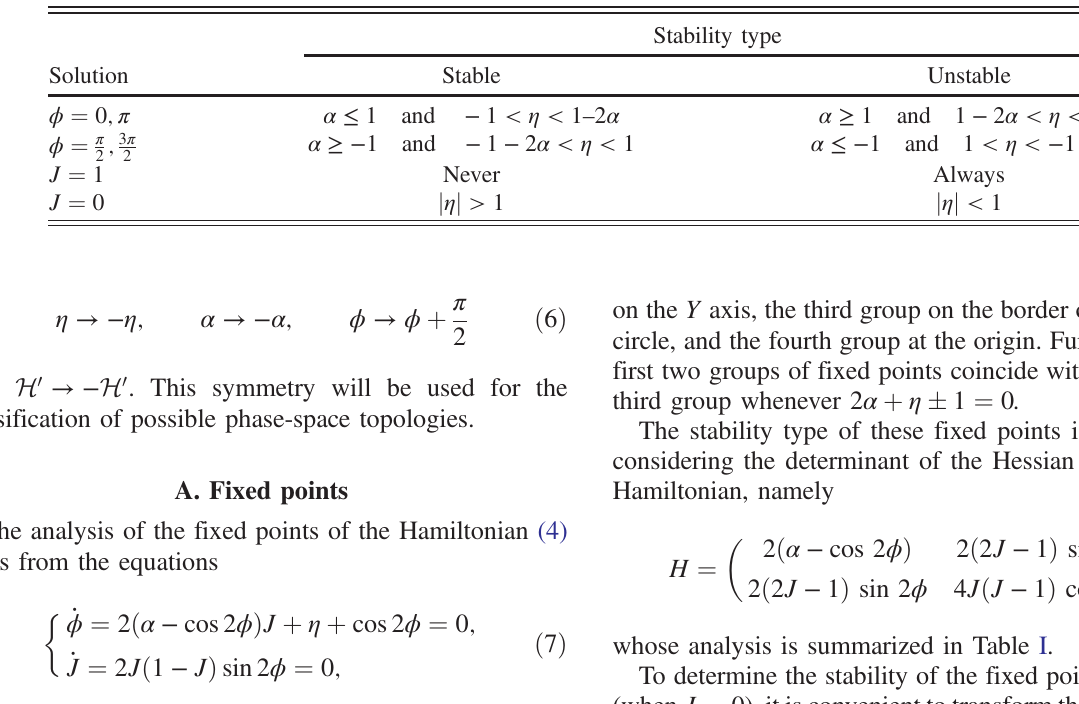
TABLE I. Analysis of the stability type of the fixed points of the Hamiltonian